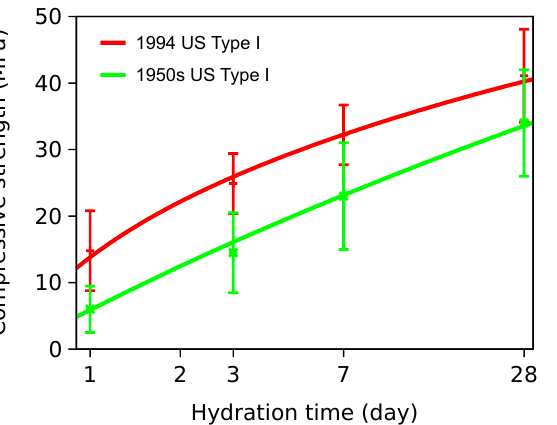
Figure 1. Compressive strength of cements produced in the 1950s (193 cements) and 1994 (>2150 cements)